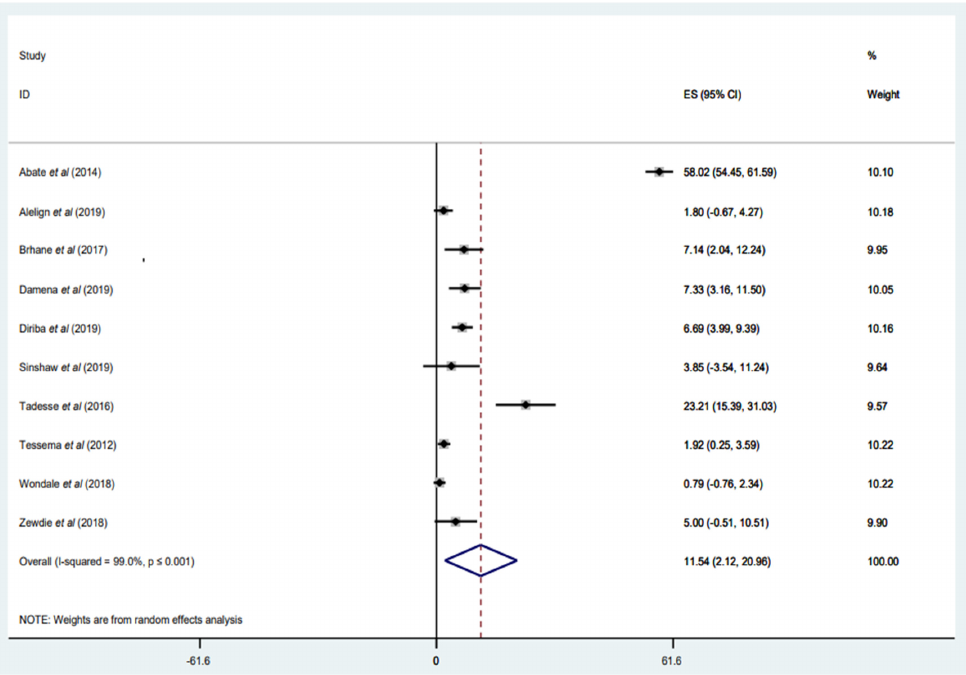
Figure 8. Forest plot showing the weighted pooled prevalence of multidrug-resistant tuberculosis (MDR-TB) among patients retreated with TB.